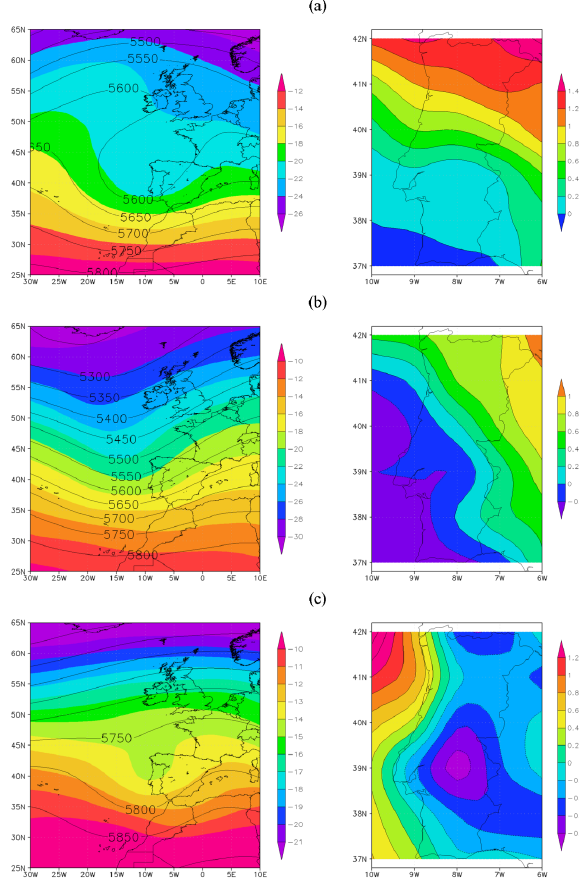
Figure 11. As in Fig. 10, but now for the composites of the JRA 500 hPa air temperature 698 Fig. 11. As in Fig. 10, but now for the composites of the JRA 500hPa air temperature and geopotential field (left panels; shading and geopotential field ( left panels ; shading in ºC and contours in gpm) and for the best 699 in ◦ C and contours in gpm) and for the best 4-layer lifted index 4-layer lifted index ( right panels ; in ºC). 700 (right panels; in ◦